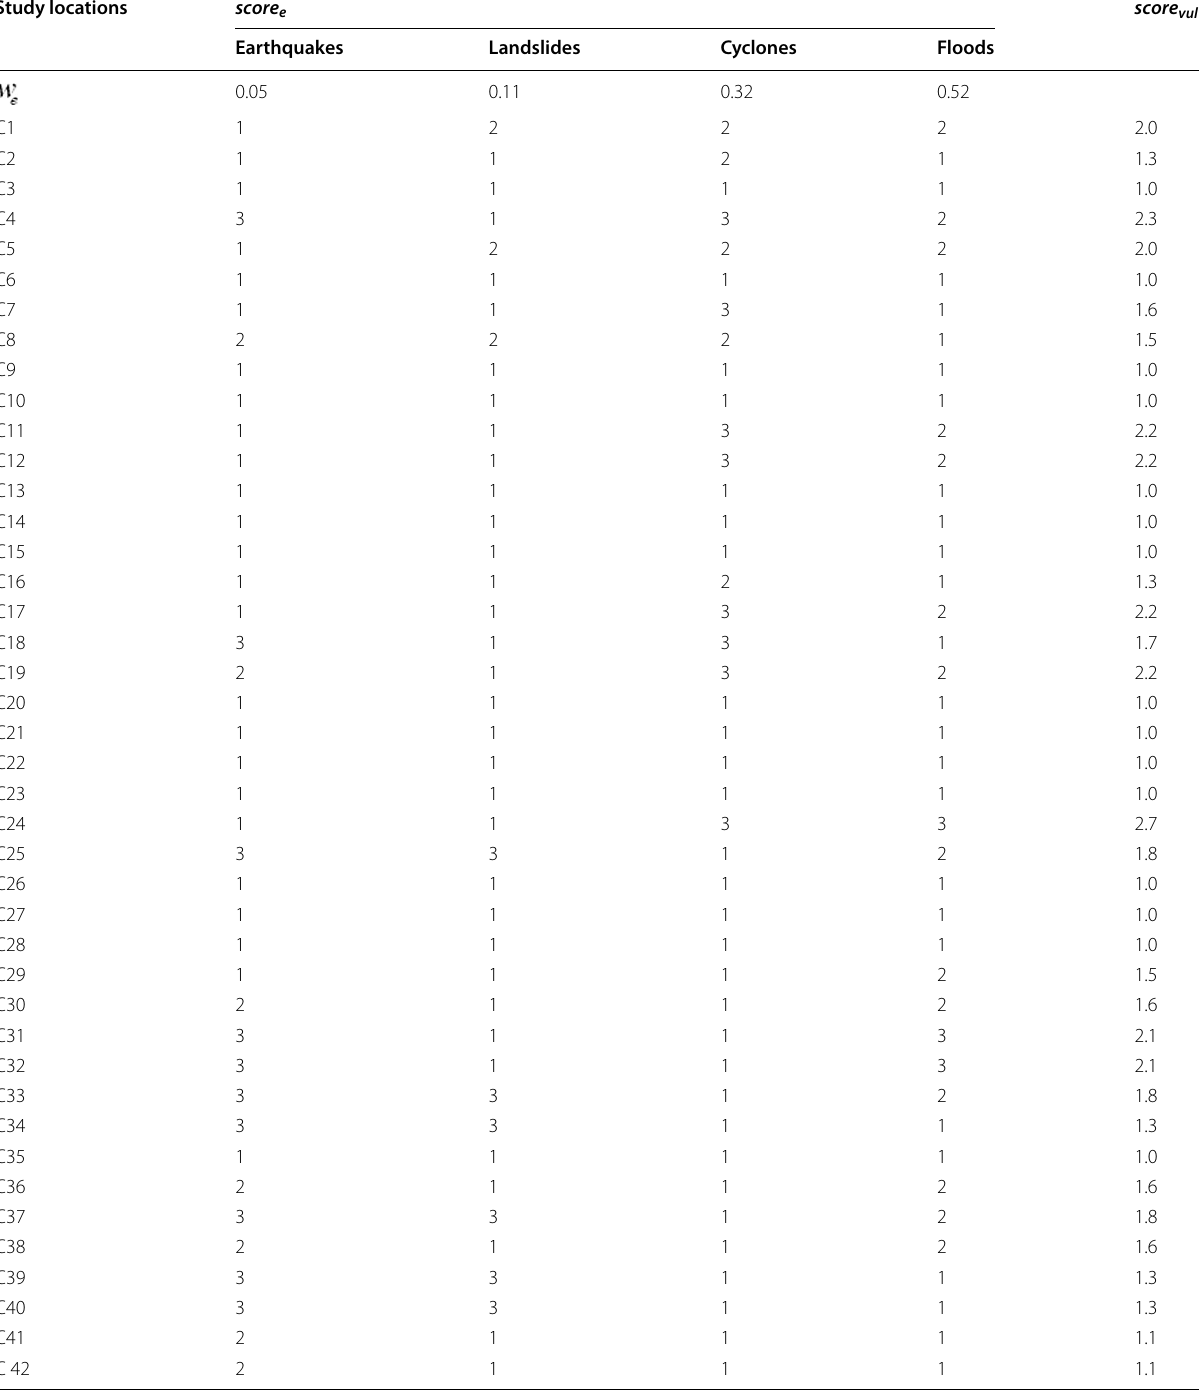
Table 7 Scores (score ) of the study locations for their vulnerability in the mentioned natural hazards. The vulnerability score vul (score ) calculated from Eq. 4 with weights (w ) vul e Study